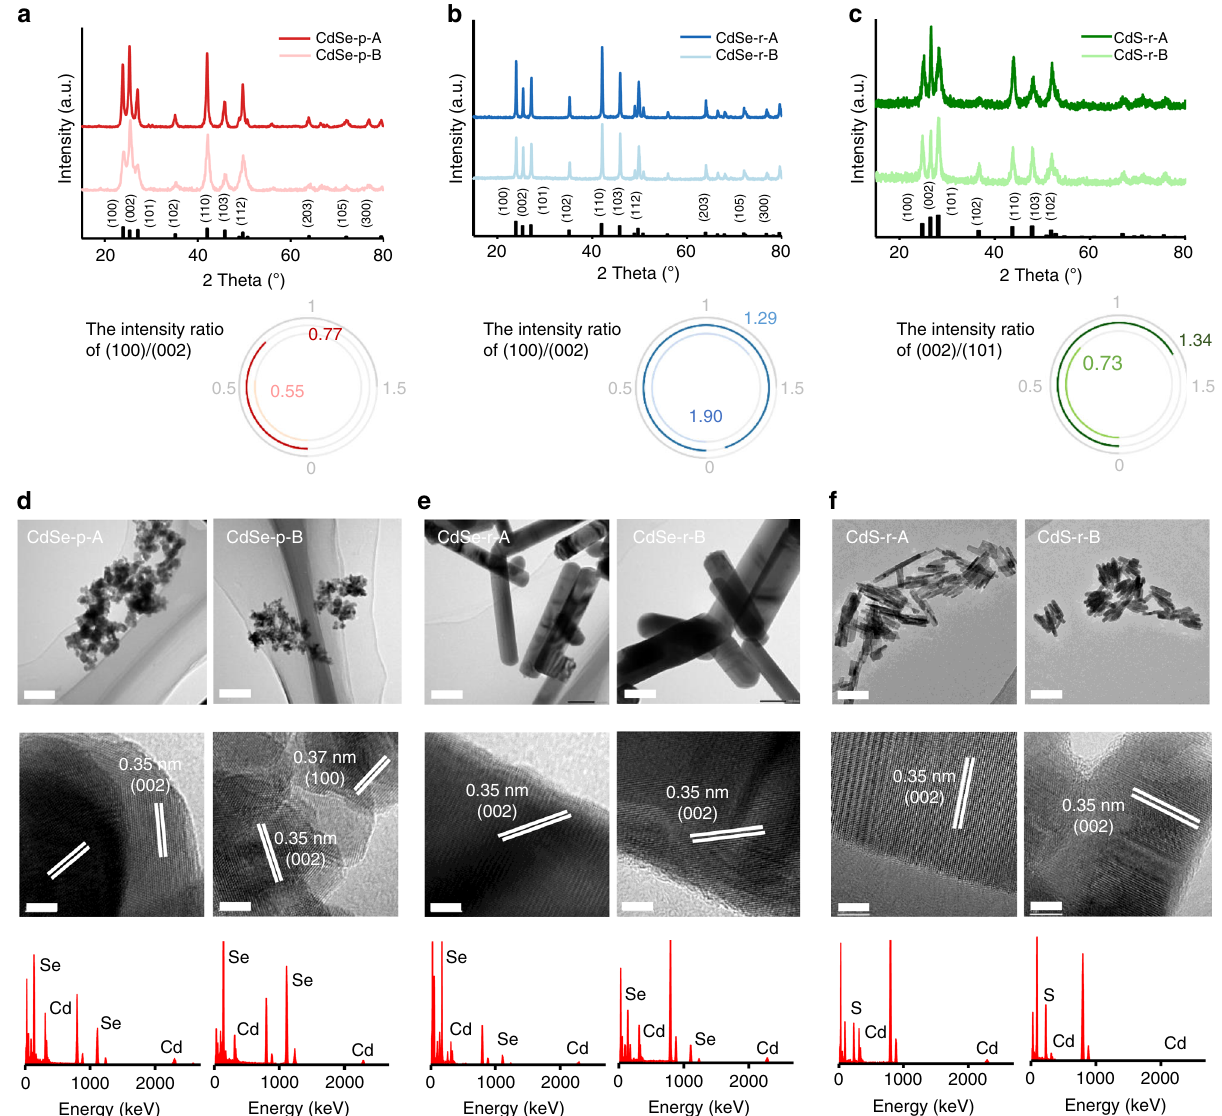
Fig. 1 Characterization of different-faceted CdSe and CdS nanocrystals. a – c X-ray diffraction (XRD) spectra of CdSe nanoparticles ( a , CdSe-p-A: dark red solid line; CdSe-p-B: light red solid line), CdSe nanorods ( b , CdSe-r-A: dark blue solid line; CdSe-r-B: light blue solid line), and CdS nanorods ( c , CdS-r-A: dark green solid line; CdS-r-B: light green solid line). The two nanomaterials in each group had different facet content (i.e., (100) vs. (002) for CdSe and (002) vs. (101) for CdS), according to the intensity ratio of the corresponding peaks in the XRD spectra. d – f Transmission electron microscopy (TEM) images and energy-dispersive spectroscopy (EDX) spectra showed that different-faceted CdSe nanoparticles ( d ), CdSe nanorods ( e ), and CdS nanorods ( f ) exhibited similar size and morphology. TEM analysis was independently repeated fi ve times, and the results were similar. Scale bar of upper panel: 100 nm. Scale bar of middle panel: 5 nm. Source data are provided as a Source Data fi (Fig. 2), whereas adsorption of the non-thiol transferrin to the Cd nanocrystals appeared to be independent of or less affected by exposed facets and occurred to a much lower extent than with thiol-rich transferrin (Fig. 4c – e).